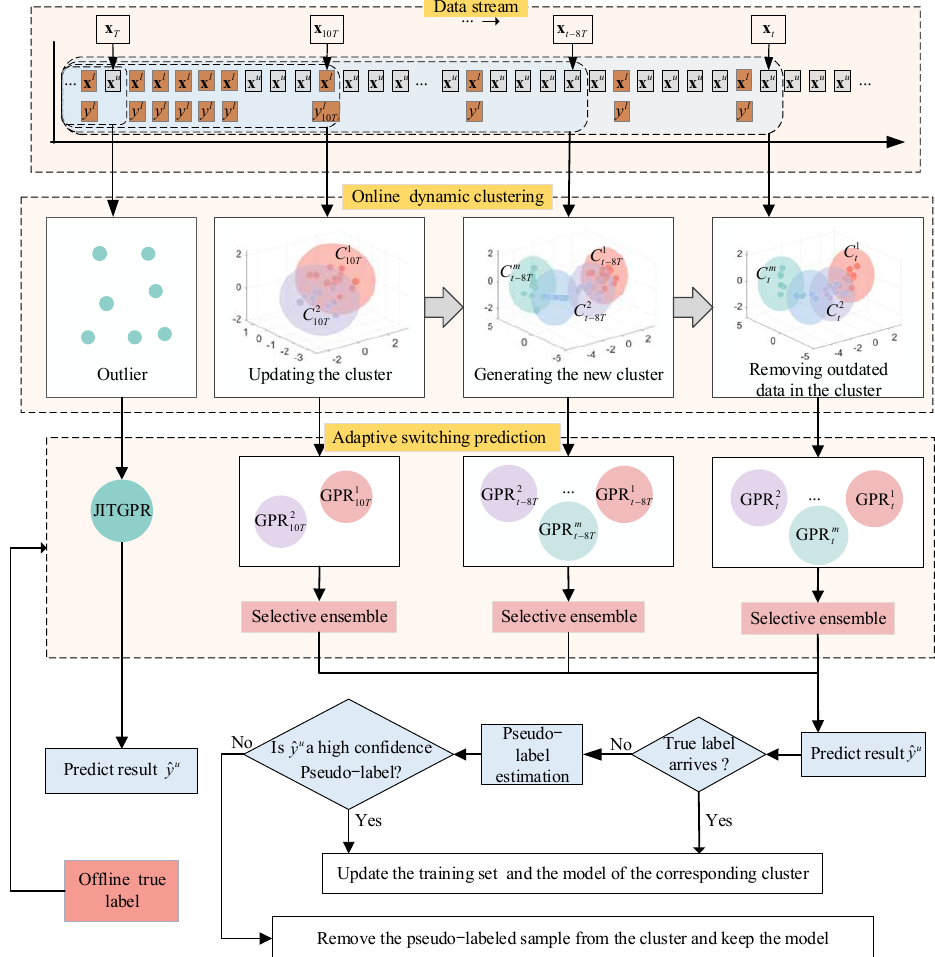
Figure 2. The overall framework of the ODCSS soft sensor method. Given the input: (1) data streams D t ={ s l